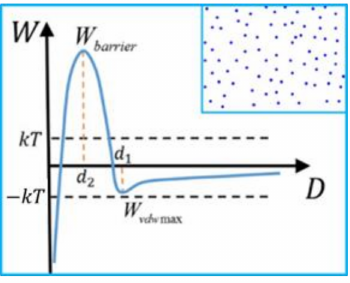
Figure 7. Interaction potentials for nanoparticle self-dispersion in molten metal with an inset to show how nanoparticles disperse in molten